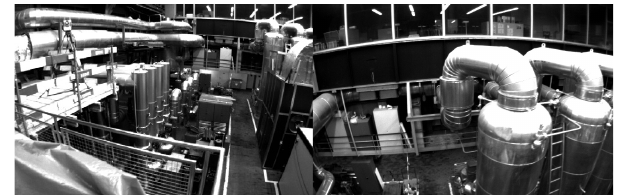
Figure 7. Scene (machine hall at the Zurich ETH) from the MH01 sequence (easy) and MH05 sequence (difficult).